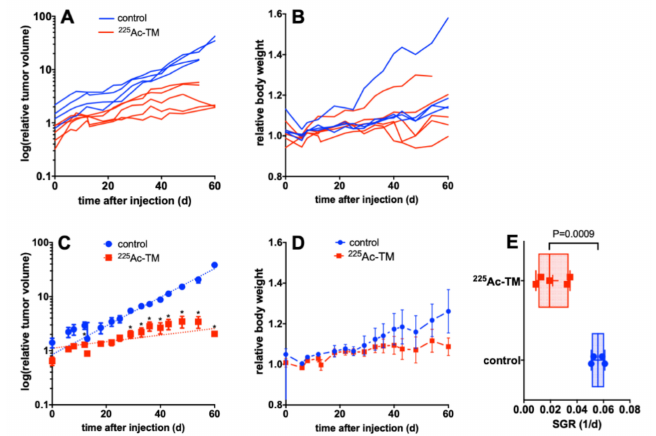
Figure 7. Targeted alpha therapy with the 225 Ac-TM in a xenograft mouse model of PCa. ( A , B ) Individual or ( C , D ) averaged curves for ( A , C ) the tumor volume, and ( B , D ) body weight changes after DOTAGA-TM (control, n = 4) or 225 Ac-TM ( n = 5) injection in tumor-bearing mice. ( E ) The SGR of the relative tumor volumes were calculated with the exponential growth equation. SGR values for tumors of the control (0.0558 ± 0.0025, n = 4) and treatment group (0.0217 ± 0.0052, n = 5) correspond to doubling times of 12.4 and 32.0 days, respectively. Data are presented as means ± SEM. For each time point, the SGR of the single animals was analyzed with an unpaired t -test without assumption of consistent SD; the calculations were corrected for multiple comparisons using Holm-Sidak method; alpha of 0.05 was defined as ‘statistically